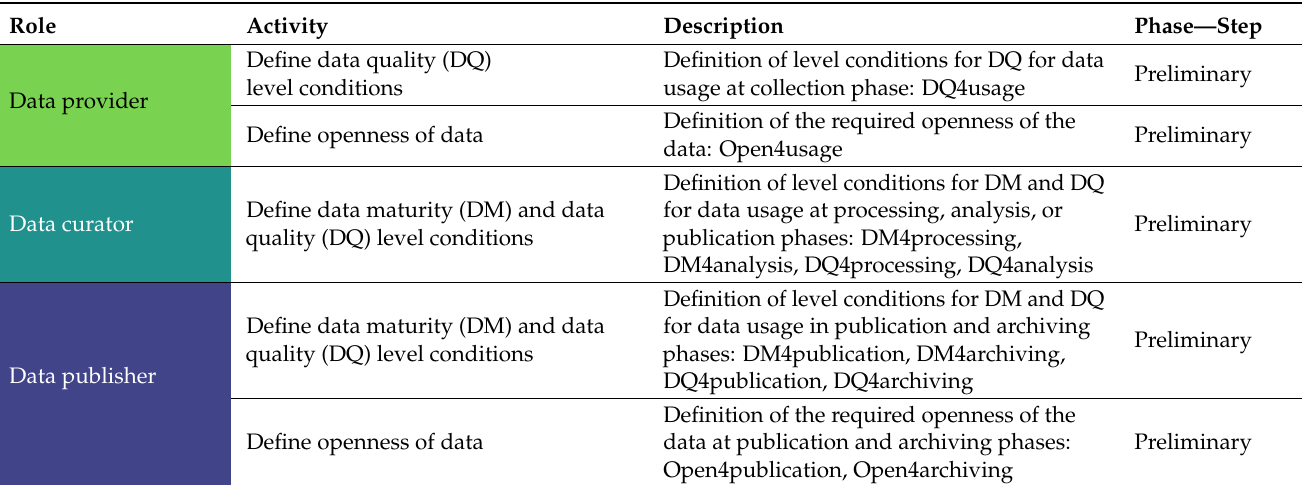
Table 8. Roles and related activities with descriptions before starting the data life cycle.